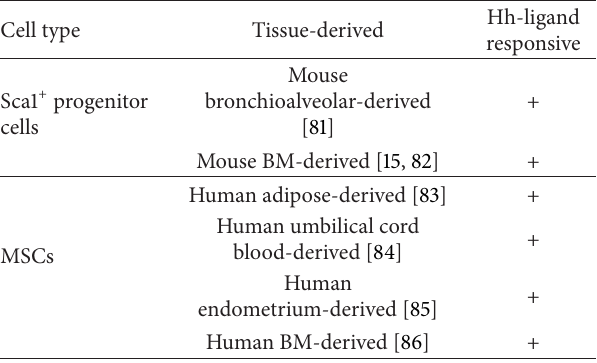
Table 2: Hh-ligand responsive Sca1 + progenitor cells and MSCs derived from multiple